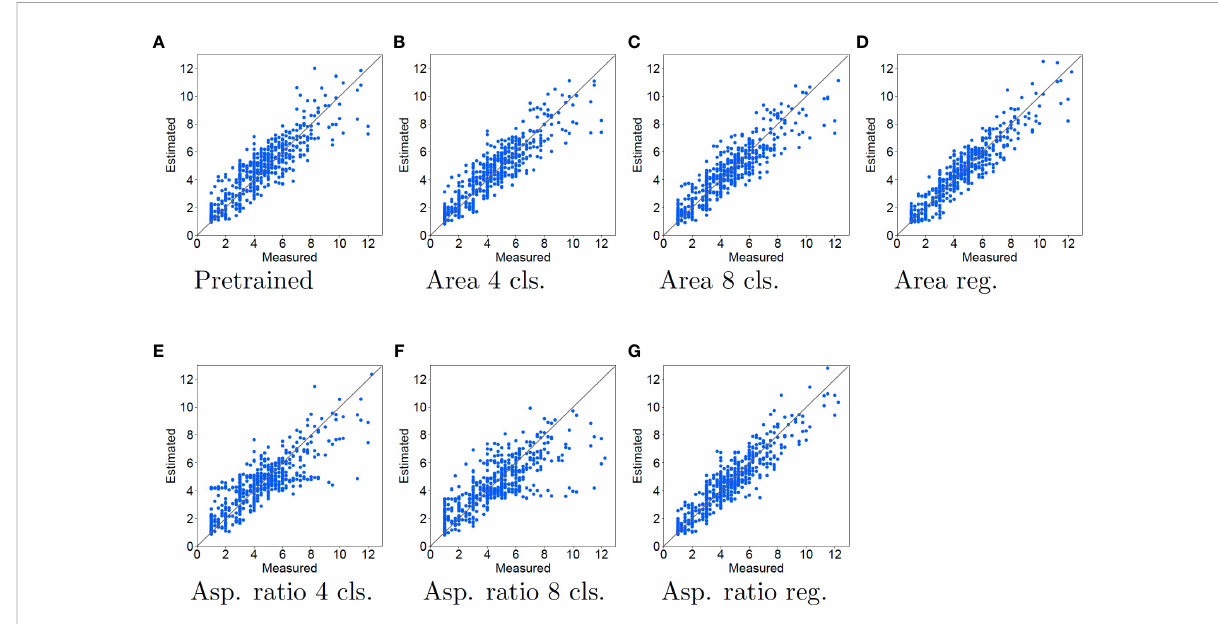
FIGURE 5 Experimental results using LR for tiller number estimation. The contents of the graph are the same as in Figure